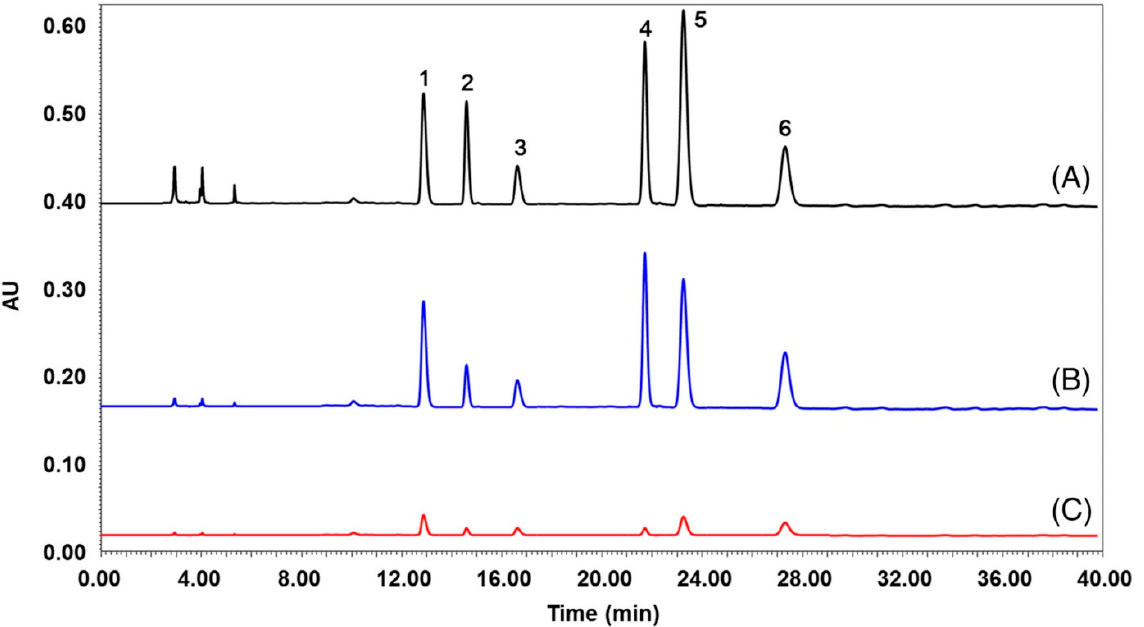
Figure 10. High-performance liquid chromatography profile of the chemical constituents of Astrag- alus membranaceus extract obtained by ultrafiltration. ( A ) Astragalus membranaceus extract (the concentration of the extract was the same as that in the ultrafiltration experiment); ( B ) compounds bound to acetylcholinesterase; ( C ) compounds bound to denatured acetylcholinesterase. 1, calycosin-7-O- β -D-glucoside; 2, pratensein-7-O- β -D-glucoside; 3, formononetin-7-O- β -Dglucoside; 4, calycosin; 5, genistein; 6, formononetin. Reprinted from [64] with permission from Wiley, ID 600051019.